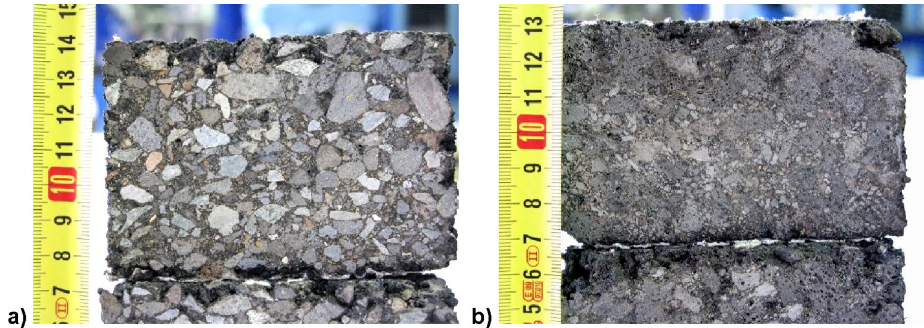
Figure 2. Cut section of cylindrical specimens: ( a ) Ref. mixture made with 6% of bitumen 35/50 pen (by total weight of mixture); ( b ) RA mixture with the same content of rubberized binder (CRMB